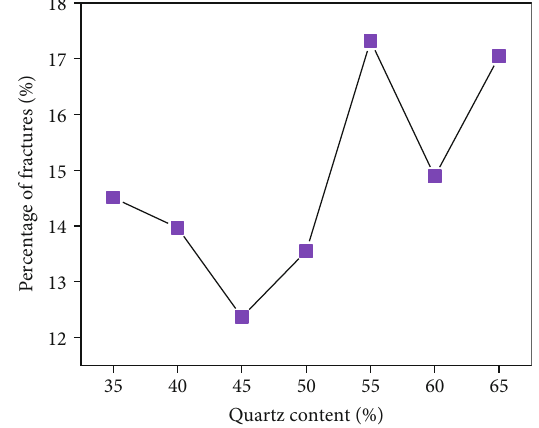
Figure 15: Percentage of fractured in fi lled shales with di ff erent quartz contents.